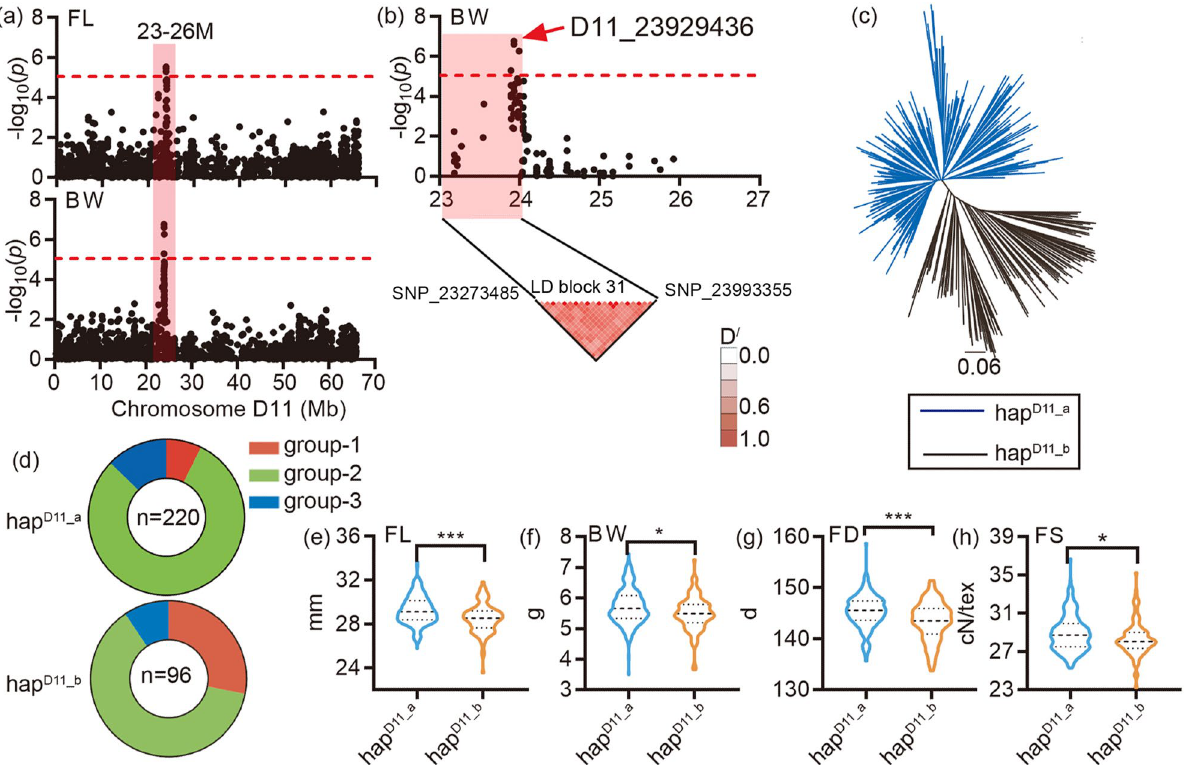
Figure 3. Identification and genotyping of the pleotropic region LD block 23 on chromosome D11: ( a ) The Manhattan block of the FL and BW, the red horizontal dashed lines indicate the significance threshold (− log 10 ( P ) > 5.27). The red box indicates the region identified by the GWAS of FL and BW, located between 23 to 26 Mb on D11 chromosome; ( b ) Local Manhattan block (top) and LD heat map (bottom). The red arrows indicate the most significance SNP in the LD block at the top and the location of the block (LD block 31) at the bottom; ( c ) A neighbor-joining tree was constructed using the SNP data located in the LD block 31. The accessions were divided into two groups, hap D11_a and hap D11_b ; ( d ) The composition of the two haplotypes, group-1 (red), group-2 (cyan) and group-3 (blue); ( e – h ) Box plots for FL, BW, FD and FS for the two haplotypes (n = 220 and 96). Center line, median; box limits, upper and lower quartiles; whiskers, 1.5× the interquartile range; dots, outliers (* P < 0.05, ** P < 0.01 and *** P < 0.001, two-sided t-test). The neighbor-joining tree ( c ) was constructed using the software PHYLIP (v3.696, https:// evolu tion. genet ics. washi ngton. edu/ phylip. html). The LD heatmap (the bottom of b ) was created by the Haploview software (https:// www. broad insti tute. org/ haplo view/ haplo view). The others were created by the software GraphPad Prism 9 (ver. 9.0.0, http:// www. graph pad.